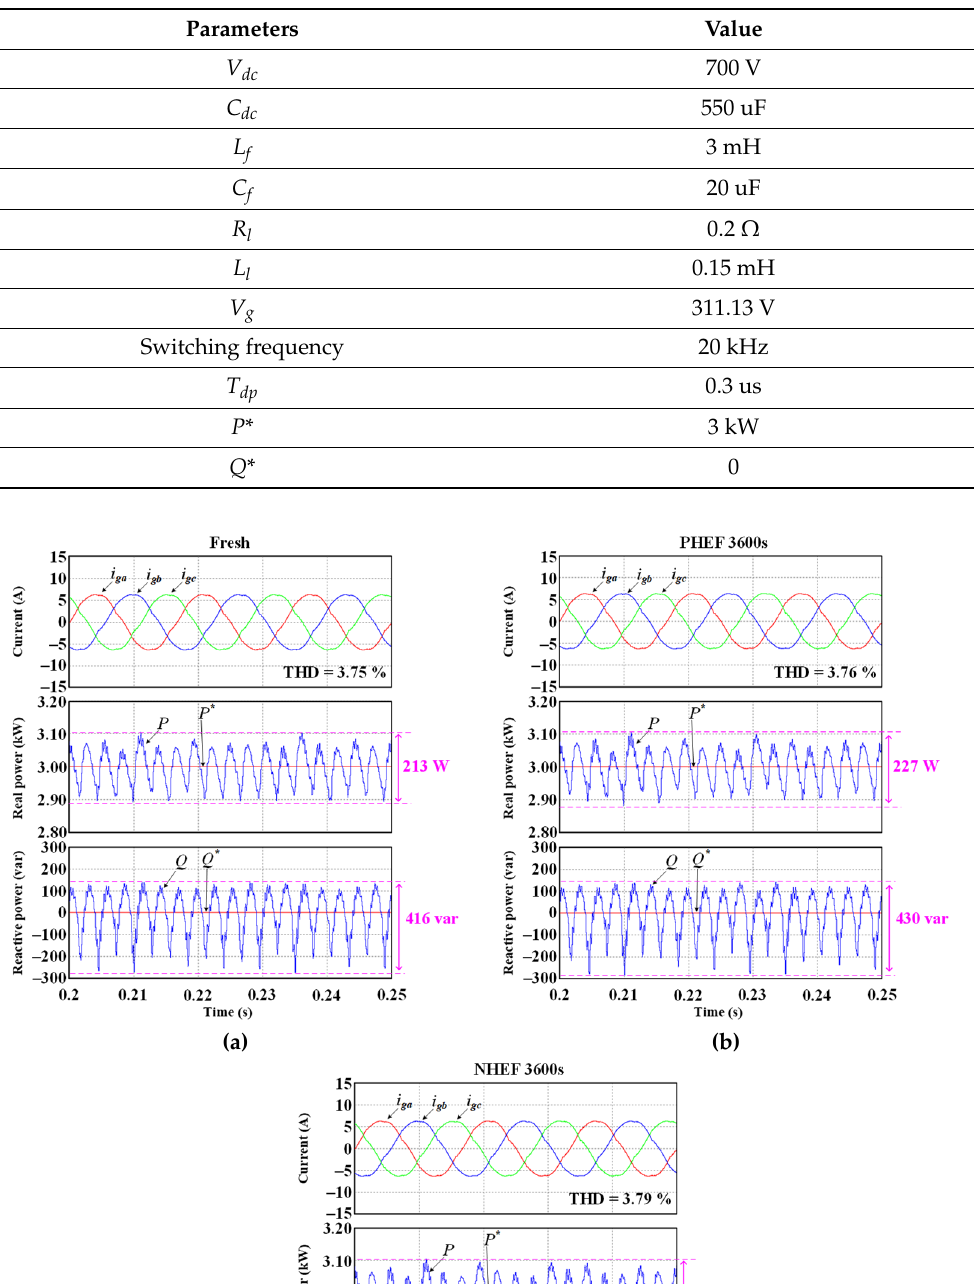
Table 4. Parameters of grid-connected voltage source inverter.